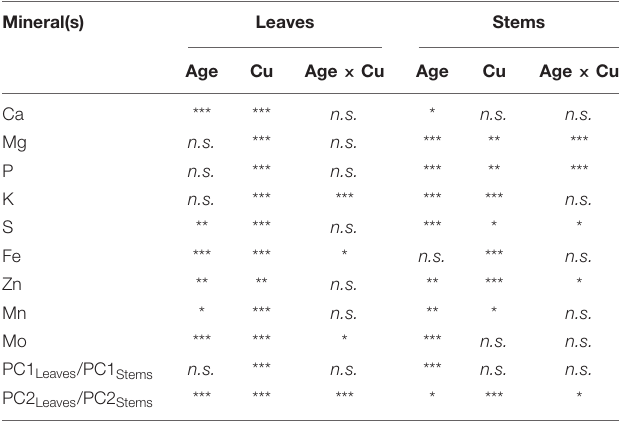
TABLE 1 | Results of two-way ANOVAs for the effects and interaction of tissue age and Cu feeding status on mineral partitioning in leaves as well as stems of hybrid white poplar ( P. tremula × P. alba ) grown in + Cu and –Cu conditions. Mineral(s) Leaves Stems